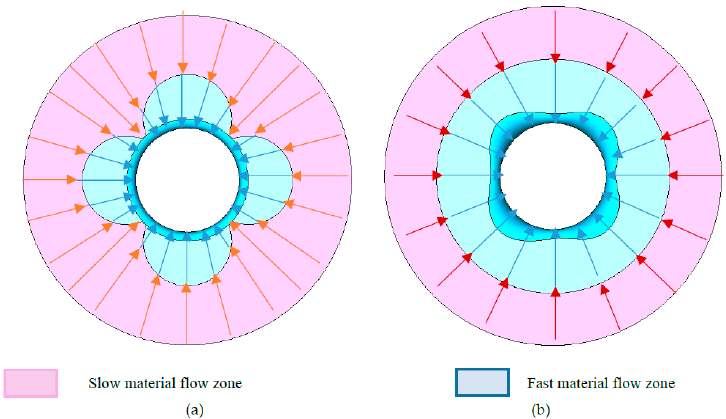
Figure 2. Principle of multi draw radius die based on the material flow characteristic: ( a ) Conventional die; ( b ) Multi draw-radius die.